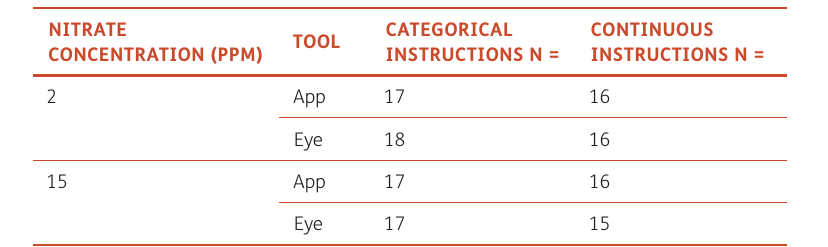
Table 1 Organizations that participated in testing events with their corresponding test dates and sample sizes. Notes: ORED = Office of Research and Economic